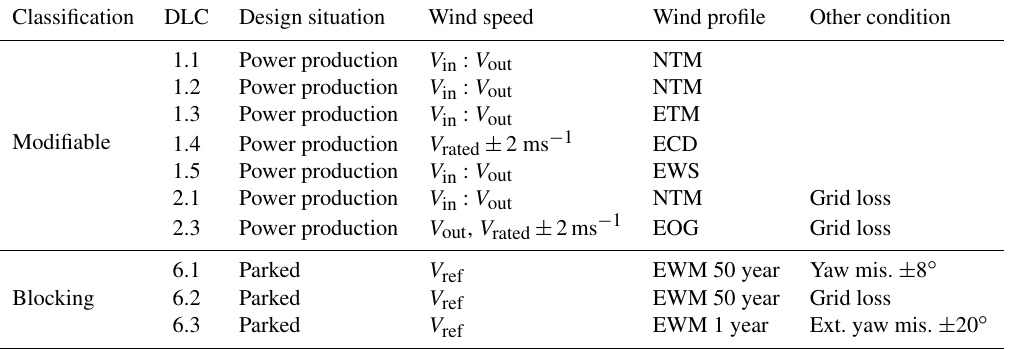
Table 1. Classification of a selection of the design load cases into modifiable and blocking (see text for a definition). NTM: normal turbulence model; ETM: extreme turbulence model; ECD: extreme coherent gust with direction change; EWS: extreme wind shear; EOG: extreme operating gust; EWM: extreme wind speed